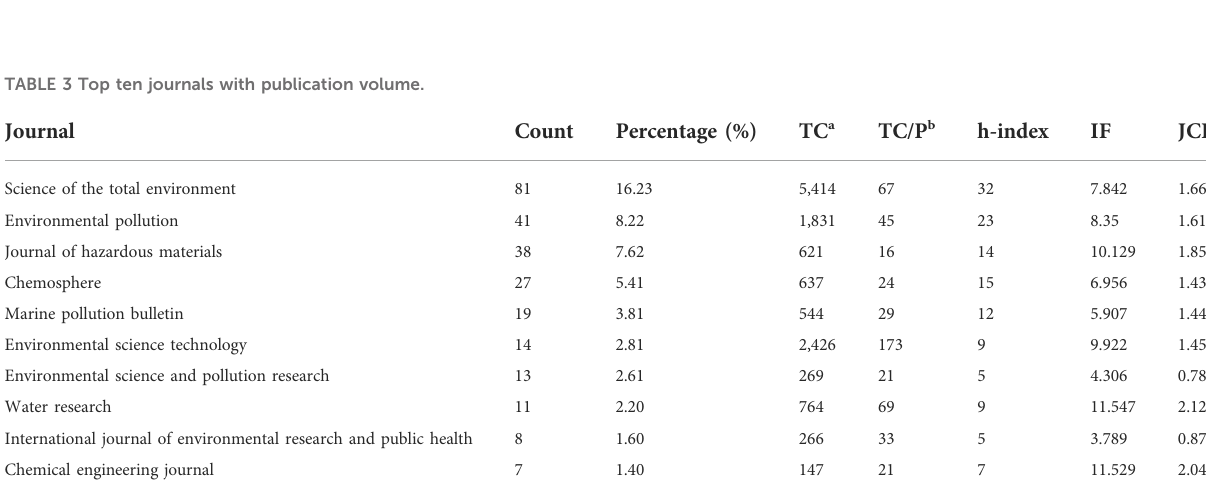
FIGURE 6 Institutions cooperation knowledge graph.